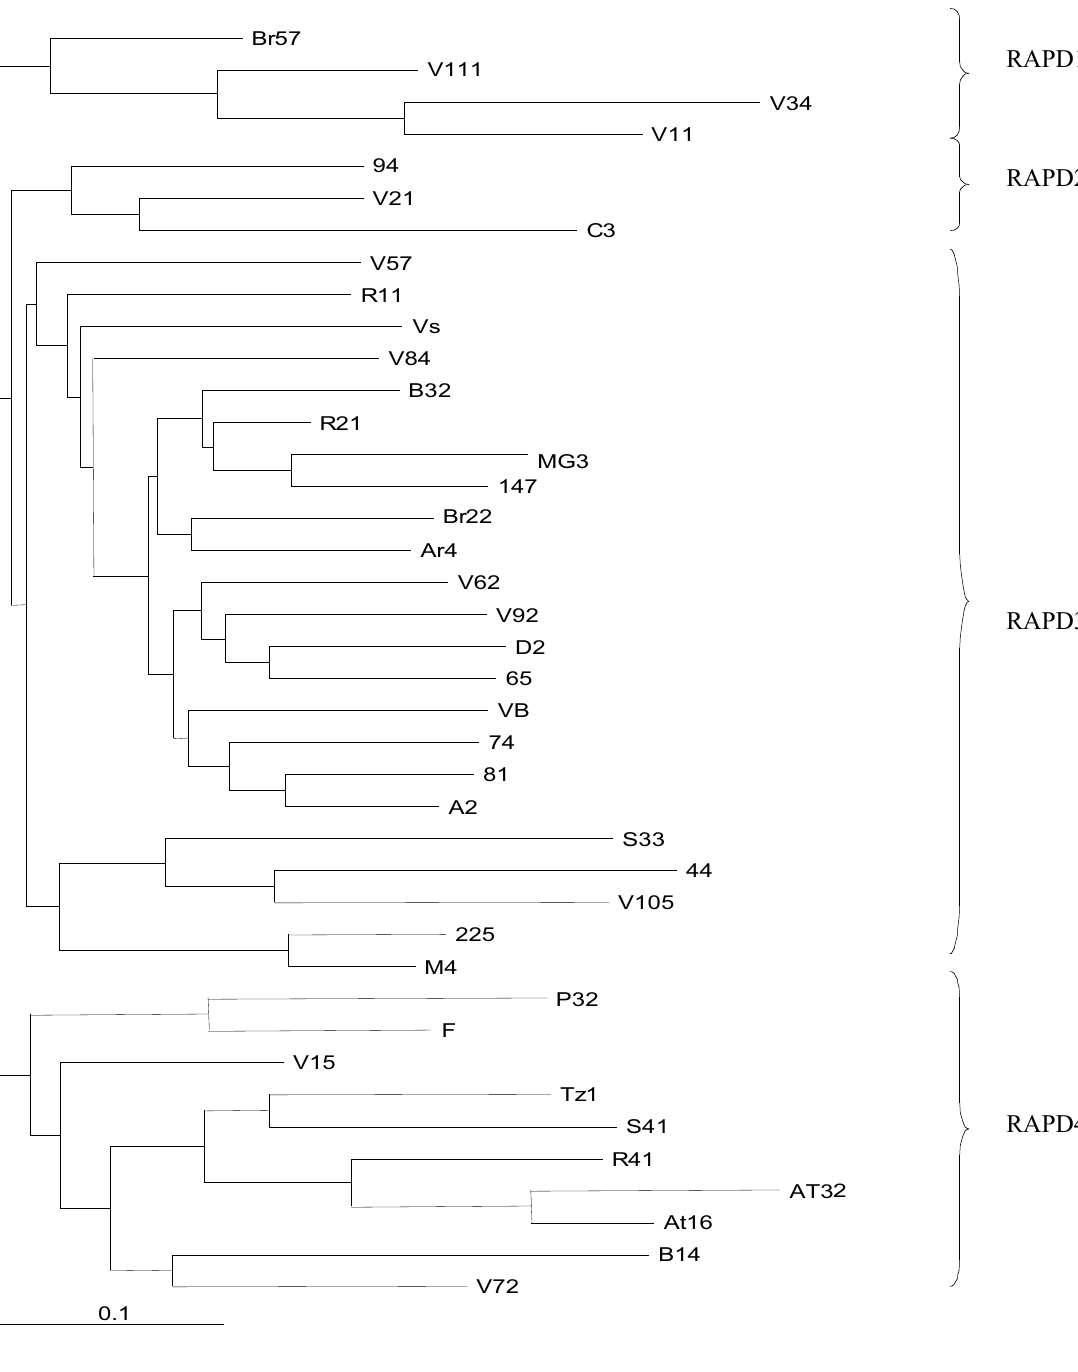
Fig. 2. Dendrogram of the 40 isolates of Verticillium dahliae listed in Table 1. The dendrogram was drawn using the DNADIST and FITCH programs of the Phylip package.